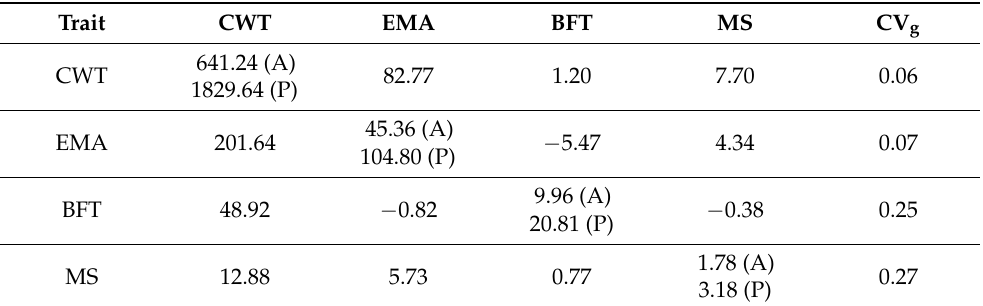
Table 3. Estimates of additive genetic (A) and phenotypic (P) variances, and covariances (above diagonal—additive genetic; below diagonal—phenotypic) of carcass traits using multiple-trait animal model in Hanwoo males 1 .